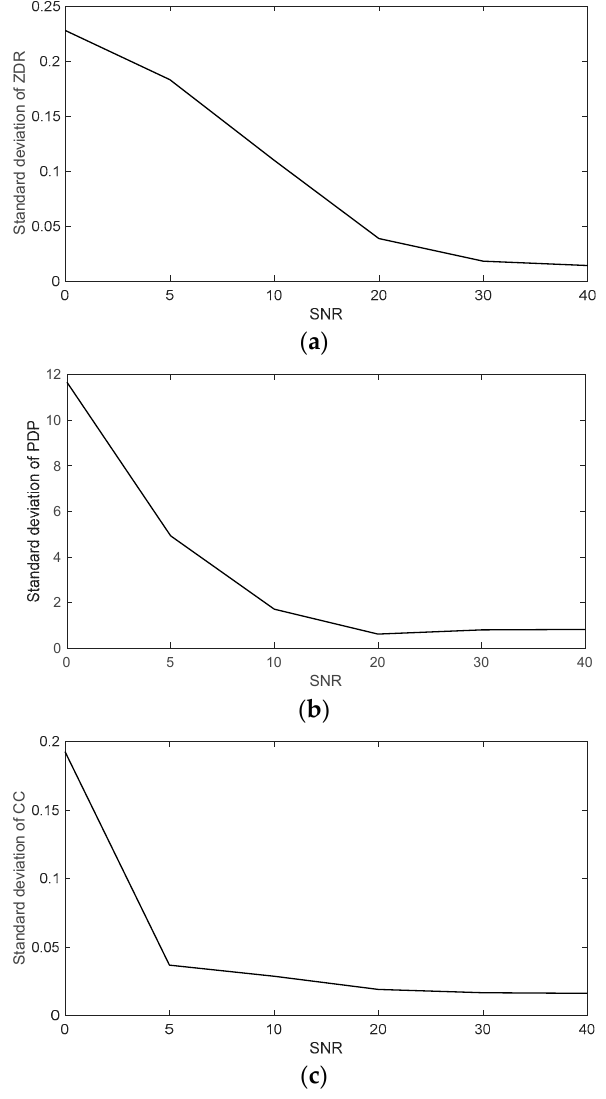
Figure 7. The standard deviation of simulated data and reference scene data. ( a ) Differential reflectivity; ( b ) differential phase; ( c ) correlation coefficient.